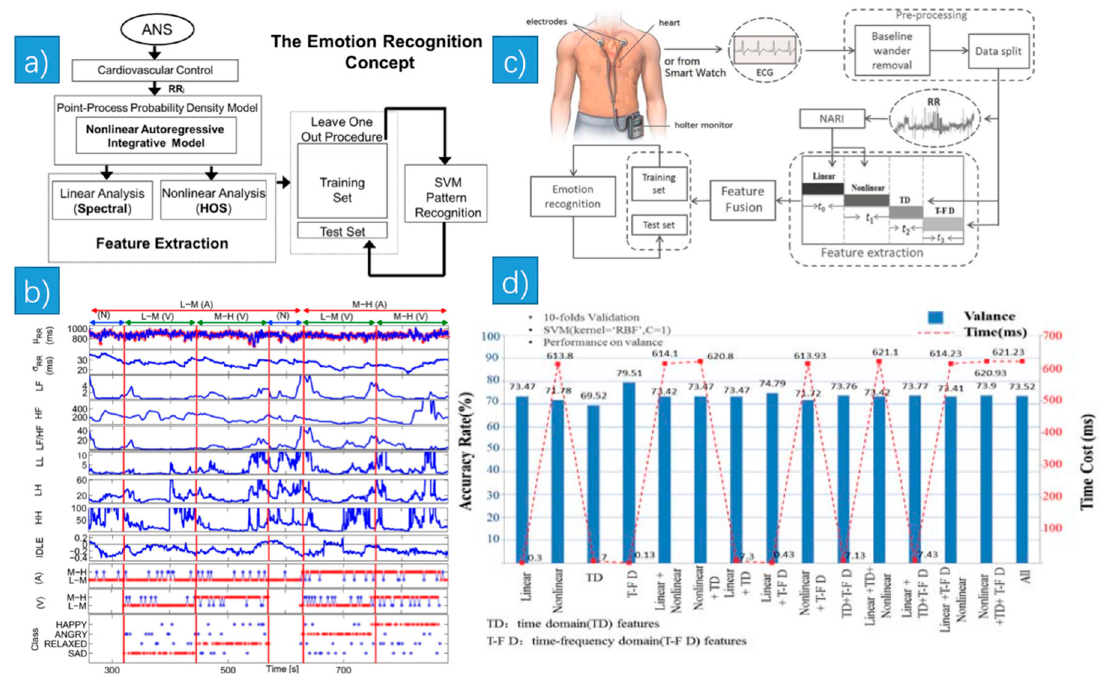
Figure 7. ( a ) Logical scheme of the overall short-time emotion recognition concept; ( b ) Instantaneous tracking of the HR V indices computed from a representative subject using the proposed NARI model during the passive emotional elicitation (two neutral sessions alternated to a L-M and a M-H arousal session); ( c ) Diagram of the proposed method; ( d ) Experimental results.